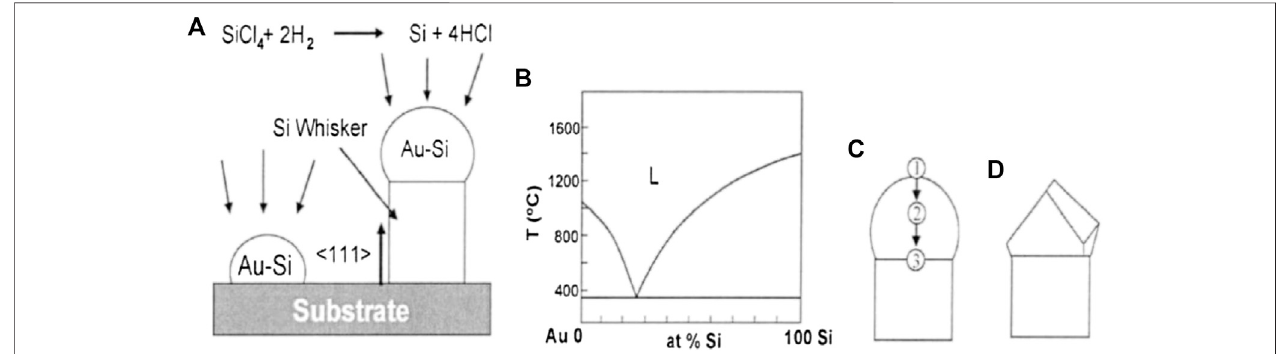
FIGURE 10 | (A) Growth of whisker catalyzed by Au-Si liquid alloy formed on Si substrate, (B) phase diagram of Au-Si, (C) diffusion path of source reactant molecule through gold droplet, (D) growth of whisker catalyzed by solid catalyst. Source : Reproduced from Ref. 31.